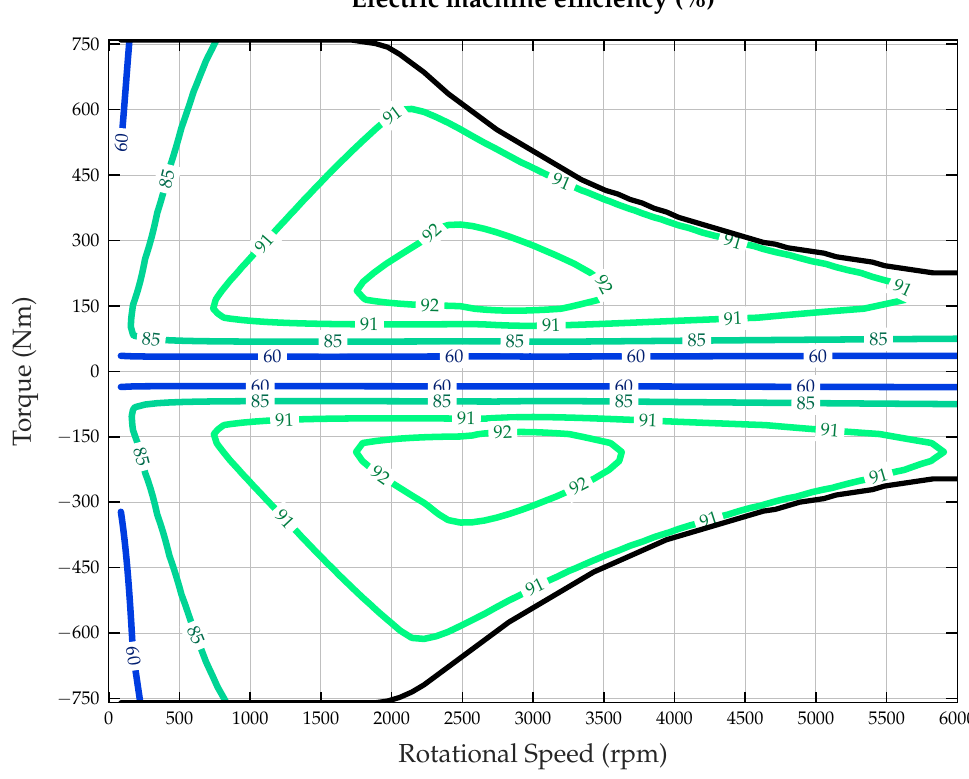
Figure 5. Efficiency map of an electric machine (150kW) obtained from FEM simulations in Motor- CAD by